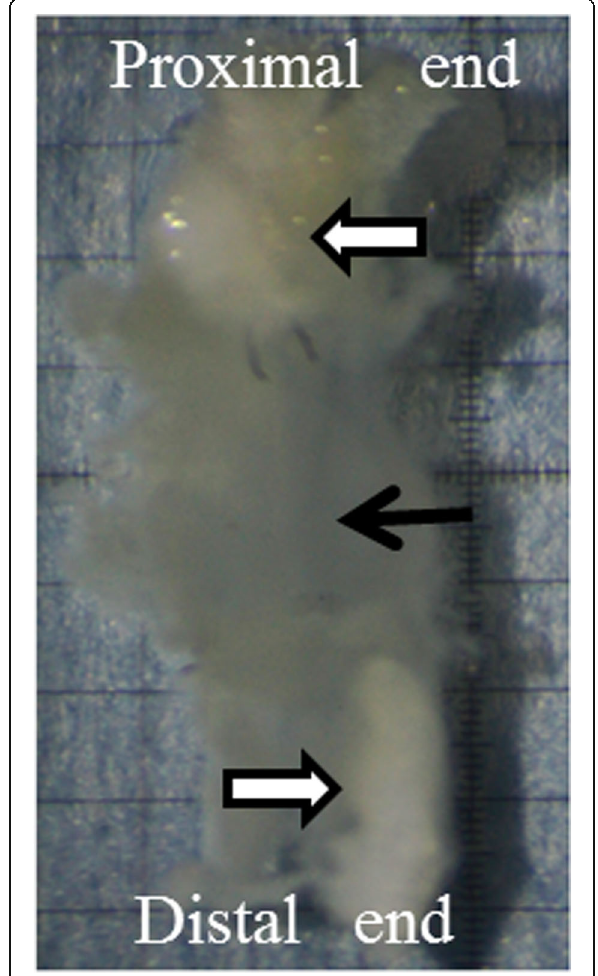
Fig. 2 Stereomicroscopic images of the tendon gel. The tendon gel (black arrow) with tendon stamps (white arrow) is